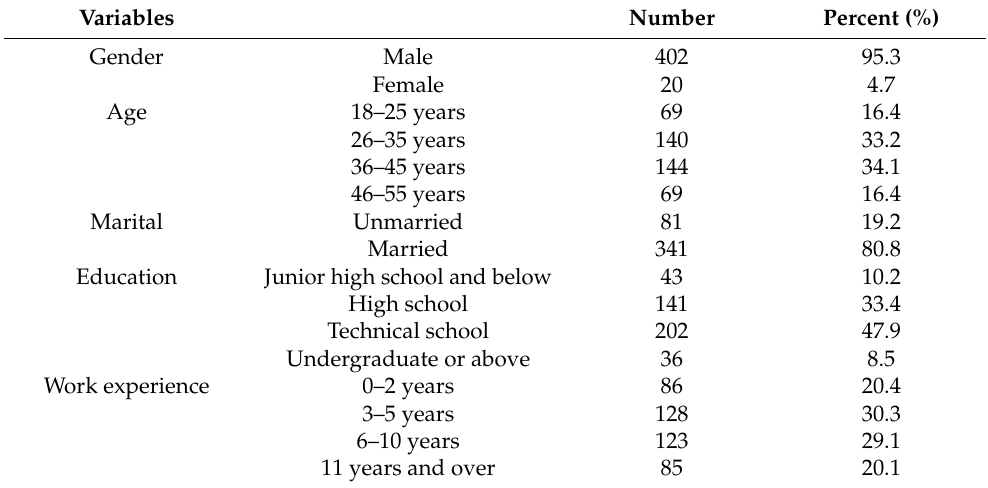
Table 1. Final participant demographics (N =